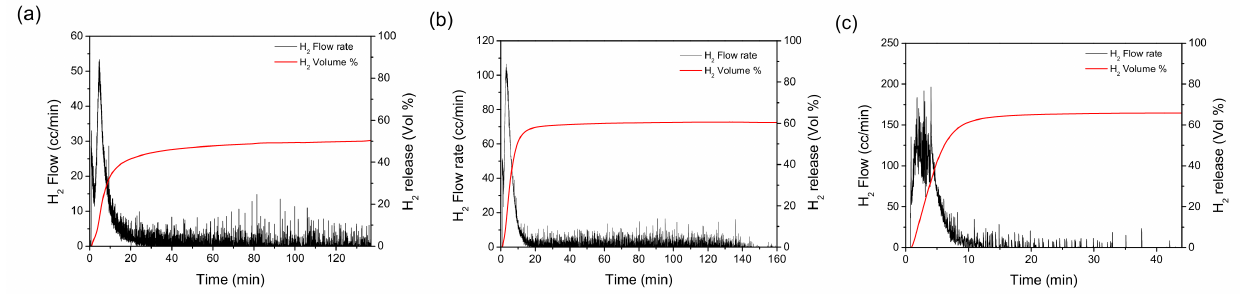
Figure 3. Dehydrogenation reaction kinetics of EBC – H at ( a ) 240, ( b ) 260, and ( c ) 280 ◦ C.